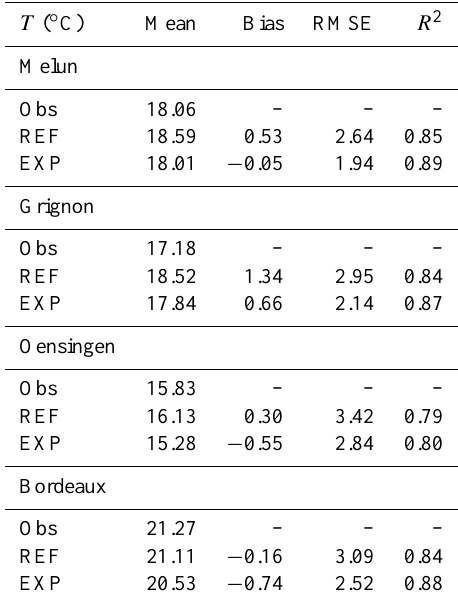
Table 1. Statistics of the 2m air temperature for the entire month of June